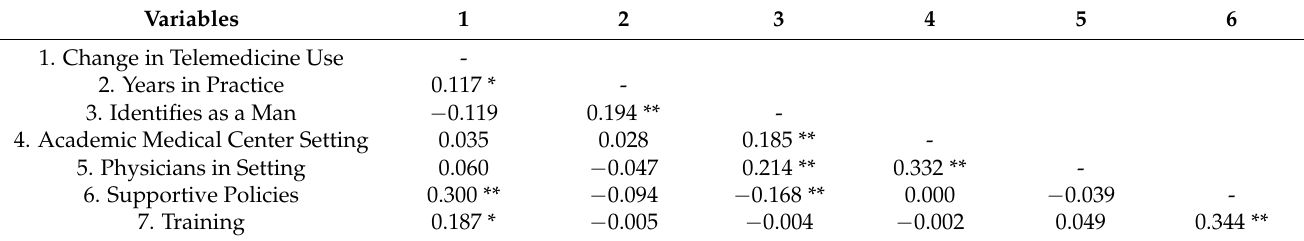
Table 3. Correlation matrix of continuous demographic variables.